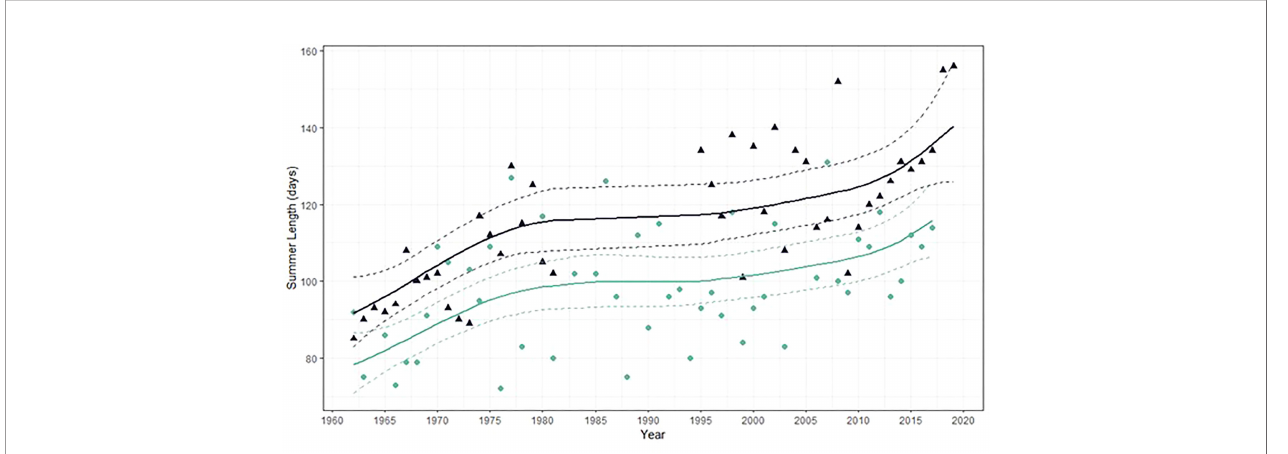
FIGURE 7 | Stressful summer length for Z. marina in both Back Sound NC (dark blue triangles) and York River VA (teal circles). Solid lines represent mean fi tted values from gamma regression with temporal correction factor and dotted lines represent 95% con fi dence intervals. York River data from Shields et al.